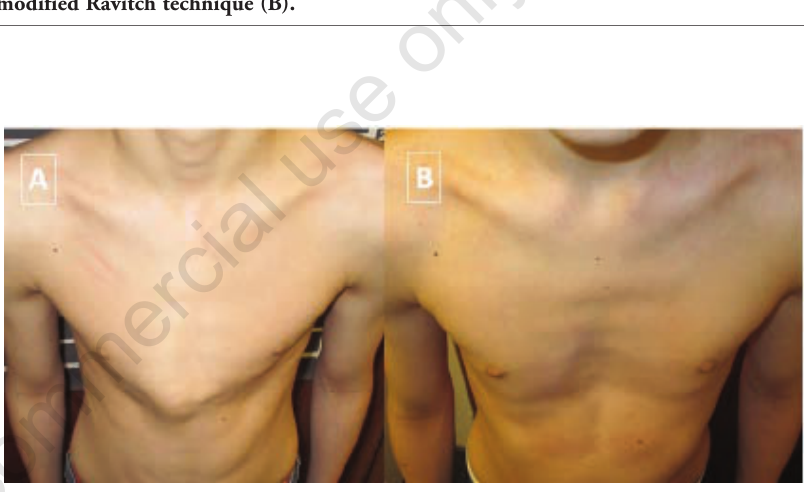
Figure 7. Pectus carinatum deformity (A) and the same patient following repair with a modified Ravitch technique (B).